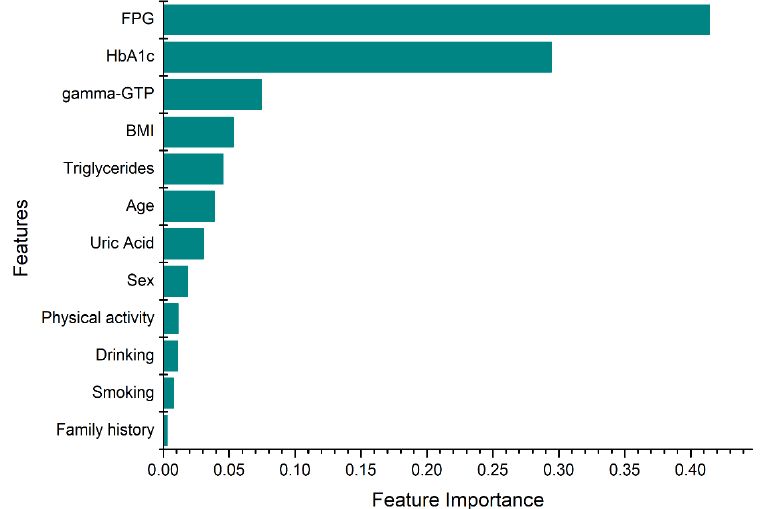
Figure 2. Feature importance ranking (FPG = fasting plasma glucose, HbA1c = hemoglobin A1c, BMI = body mass index, gamma-GTP = gamma glutamyl transpeptidase).